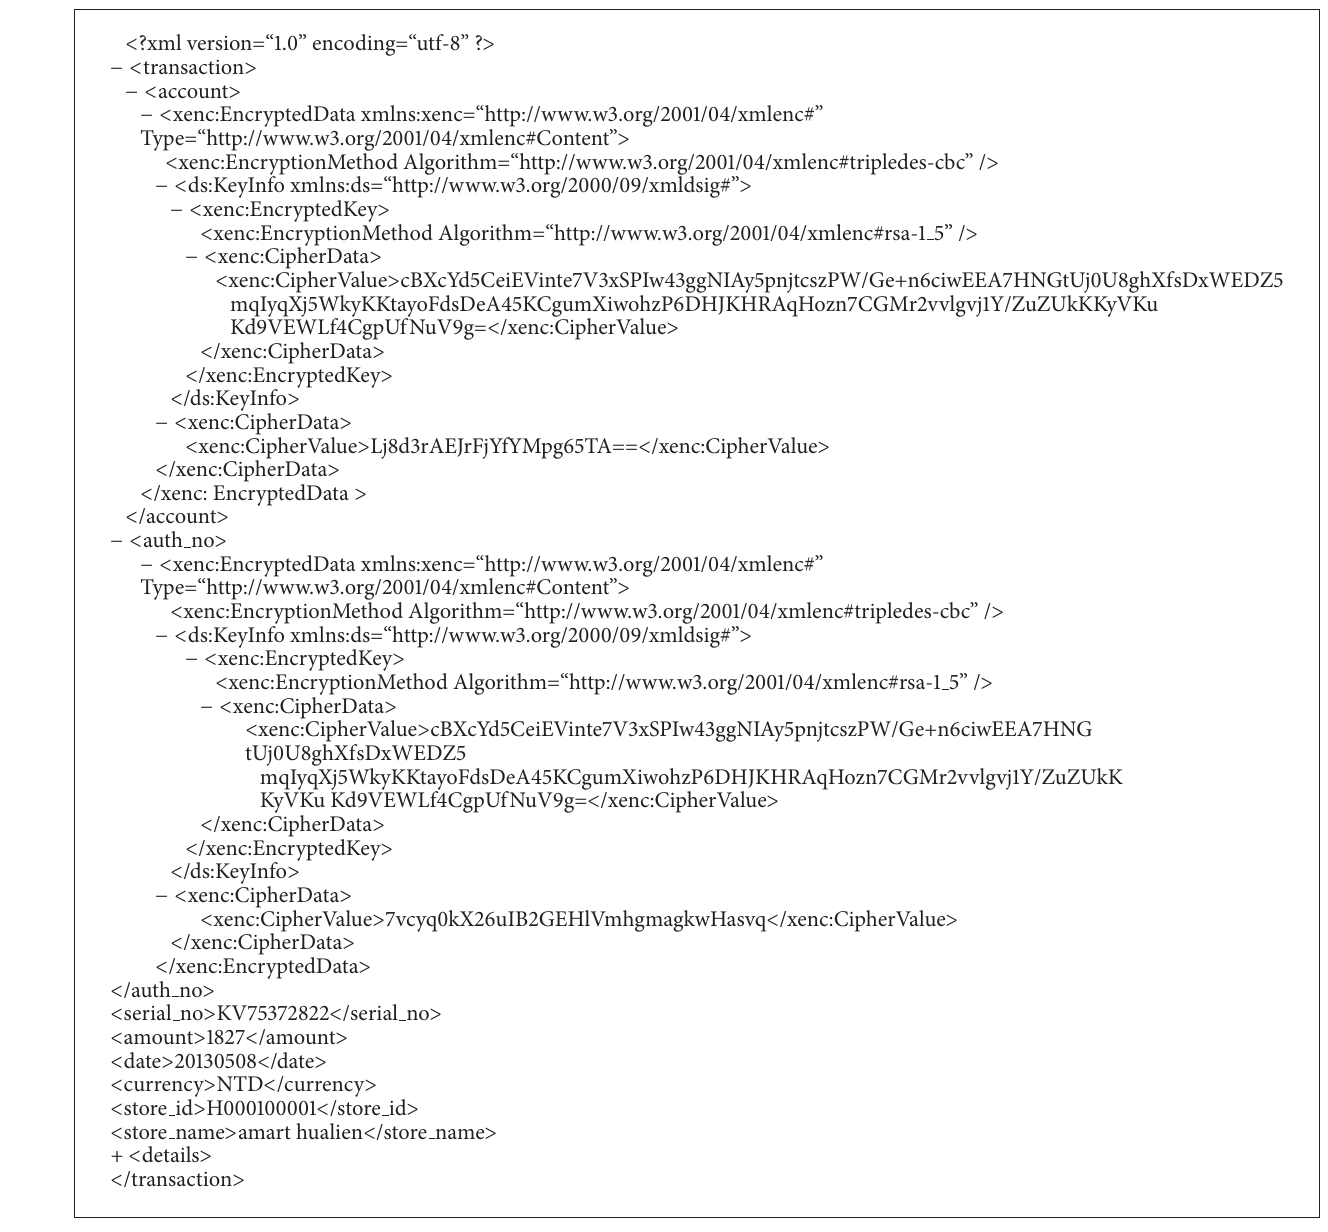
Algorithm 4: An example of encrypted data in a